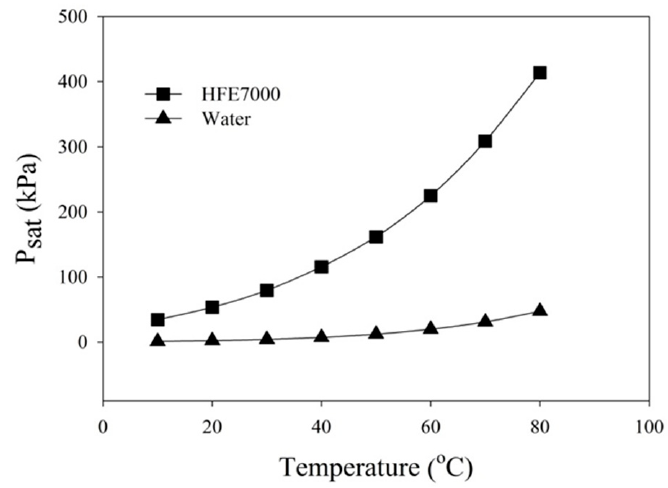
Figure 5. Liquid-vapor saturation curve of water and HFE-7000.